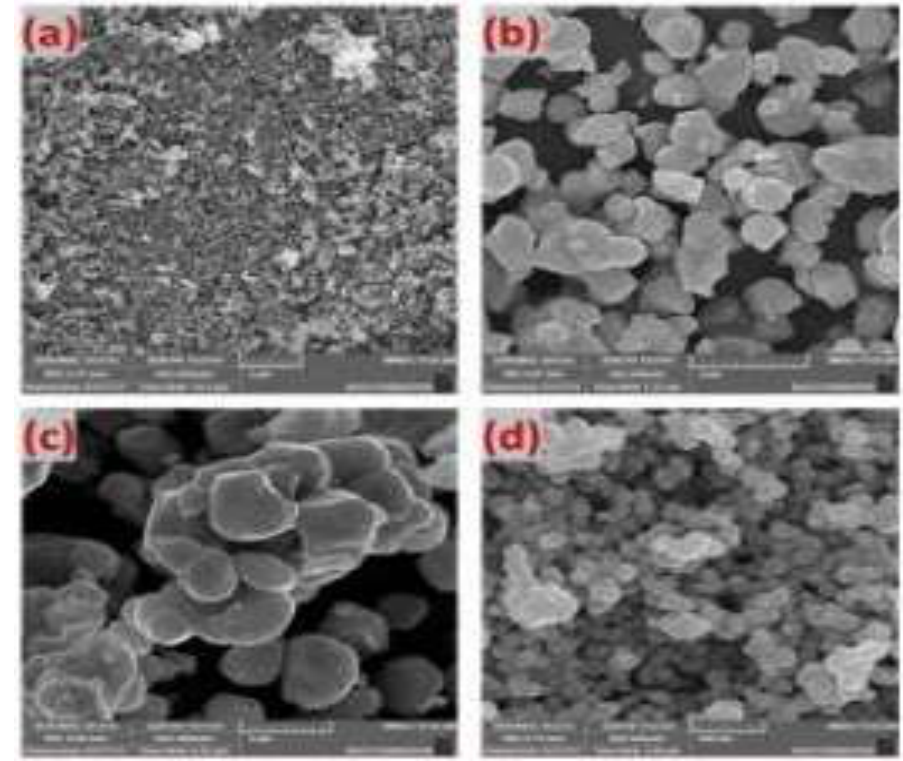
Figure 14: Scanning electron microscopy for (micro& Nano BaTiO 3 ) powders with different magnification,(a) SEM magnification 10.0X, 2µm, (b) SEM magnification 20.0X, 2µm, (c)SEM magnification 30 X , 1 µm, (d) SEM magnification 50.0X,